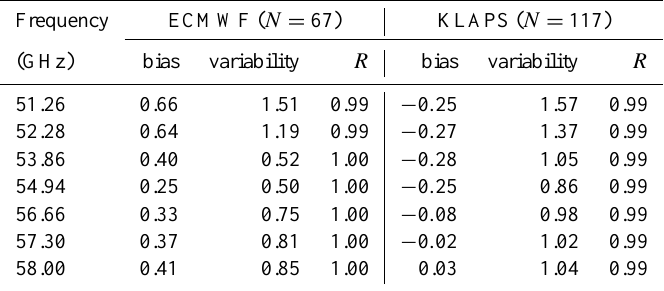
Table 1. Error statistics of the simulated T b ( T E and T K ) obtained from the radiative transfer simulation with the input profiles of temper- b b ature and humidity from the NWP data, compared to the simulated T b ( T R ) with the input profiles obtained by the radiosonde. (Here and b afterwards, the bias and variability are obtained from the average and standard deviation of difference between the two values, respectively). N indicates the number of collocated NWP data with radiosonde profile data